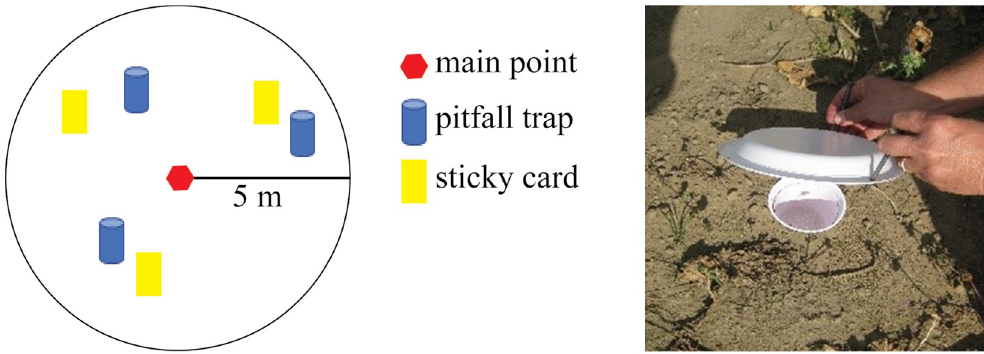
Fig 2. A. Diagram of sampling strategy. Main point indicates location within field (see Fig 1). B. Photo of pitfall trap set